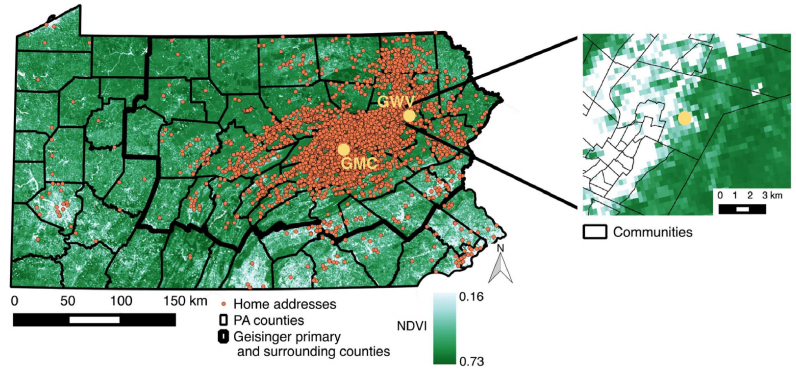
Figure 4. Distribution of greenness (normalized difference vegetation index (NDVI)) statewide overlaid with the location of Geisinger Medical Center (GMC) and Geisinger Wyoming Valley (GWV), the delivery hospitals, and most recent home addresses of mothers who delivered at the Geisinger Health System, Pennsylvania (PA),